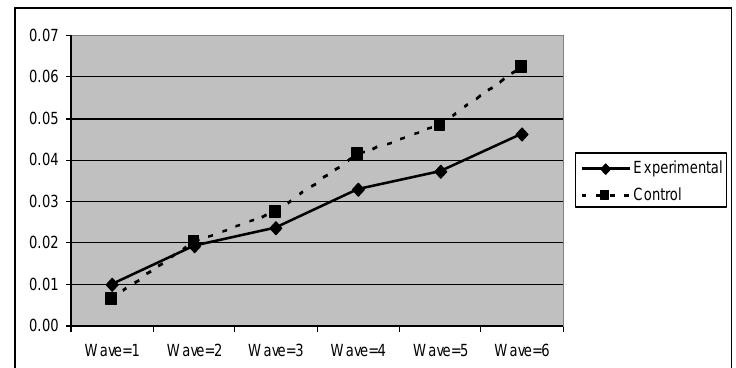
FIGURE 11 . Growth trajectories of the experimental group (Tier 1 participants who perceived the program as effective) and control group using the item score of drinking alcohol as the outcome indicator.